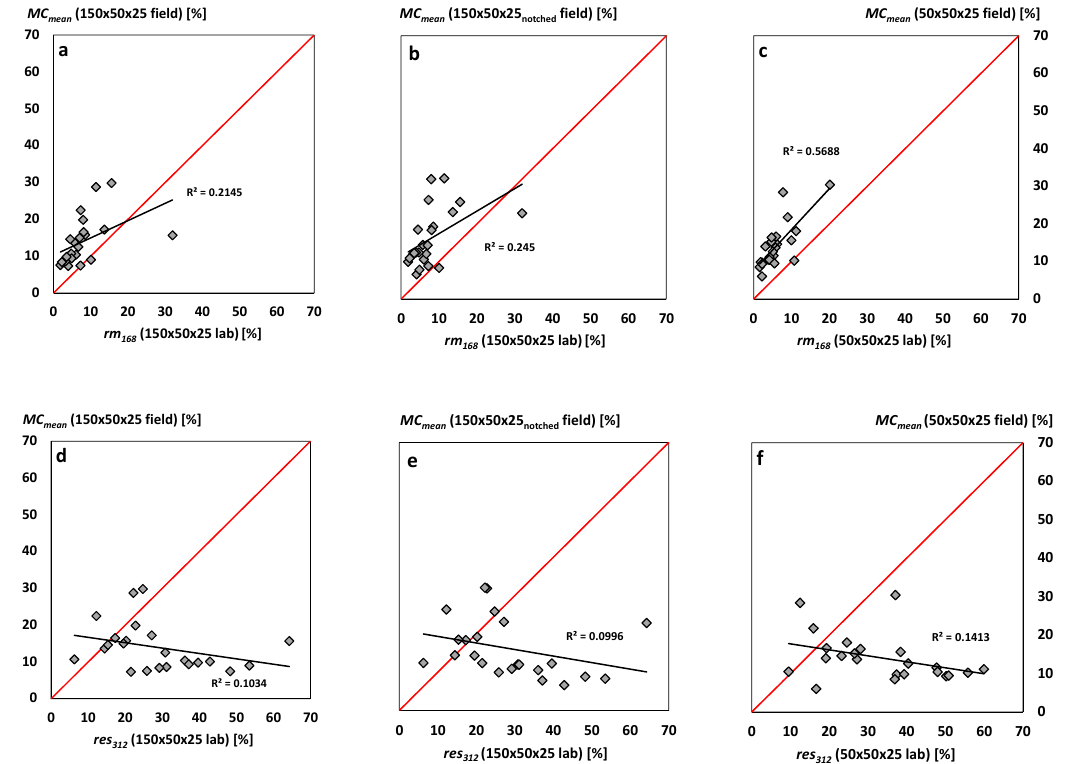
Figure 8. Interrelationship between MC mean (%) measured during outside exposure and rm 168 ( a – c ) and res 312 ( d – f ) calculated as moisture content (%) in submersion ( a , b , d , e ) and floating tests ( c , f ) according to [5].